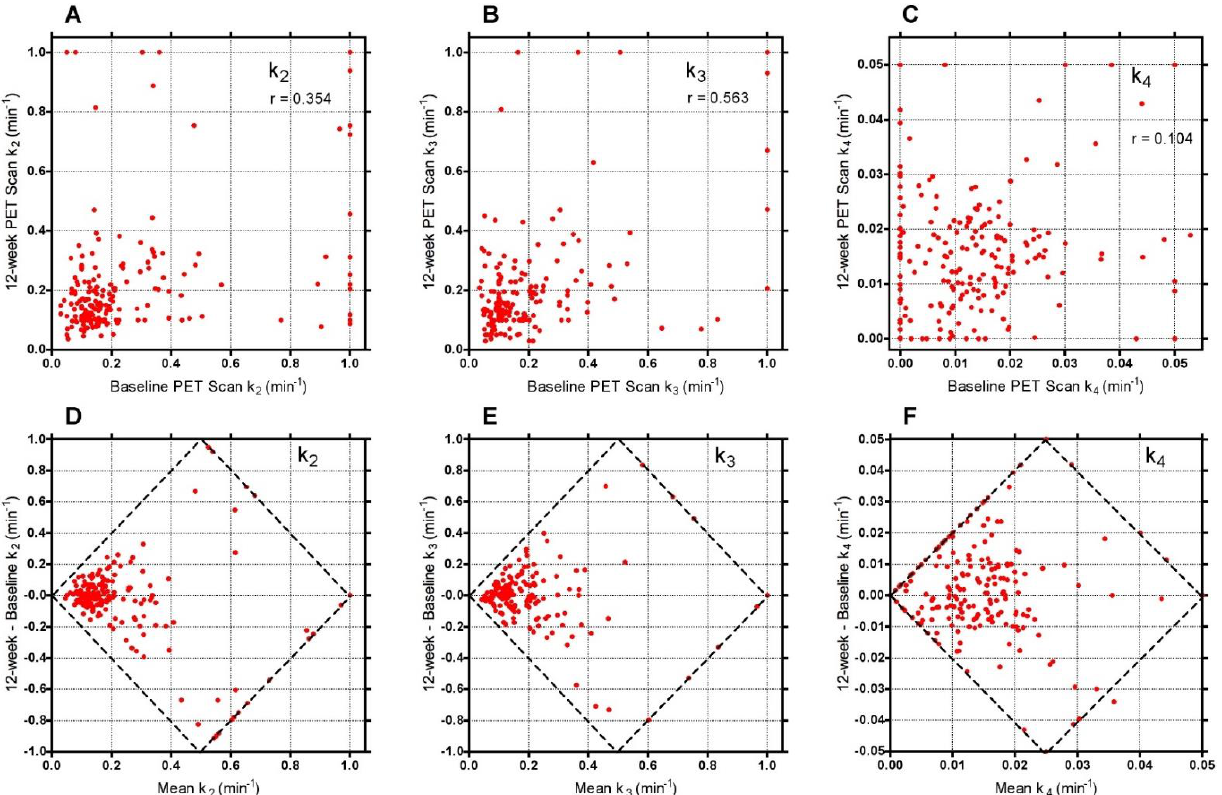
Figure A3. Scatter plots of 60-min Hawkins model k-number values for the baseline and 12-week scans for: ( A ) k 2 ; ( B ) k 3 ; ( C ) k 4 . The graphs in ( D – F ) show the respective Bland-Altman plots. The diamond-shaped dashed lines show the limits imposed by the restrictions placed on the values of the three rate constants. Points in this figure with k 2 or k 3 > 0.5 min − 1 or k 4 > 0.03 min −1 are predominantly measurements at the FN or TRAB VOIs with poor AIC.